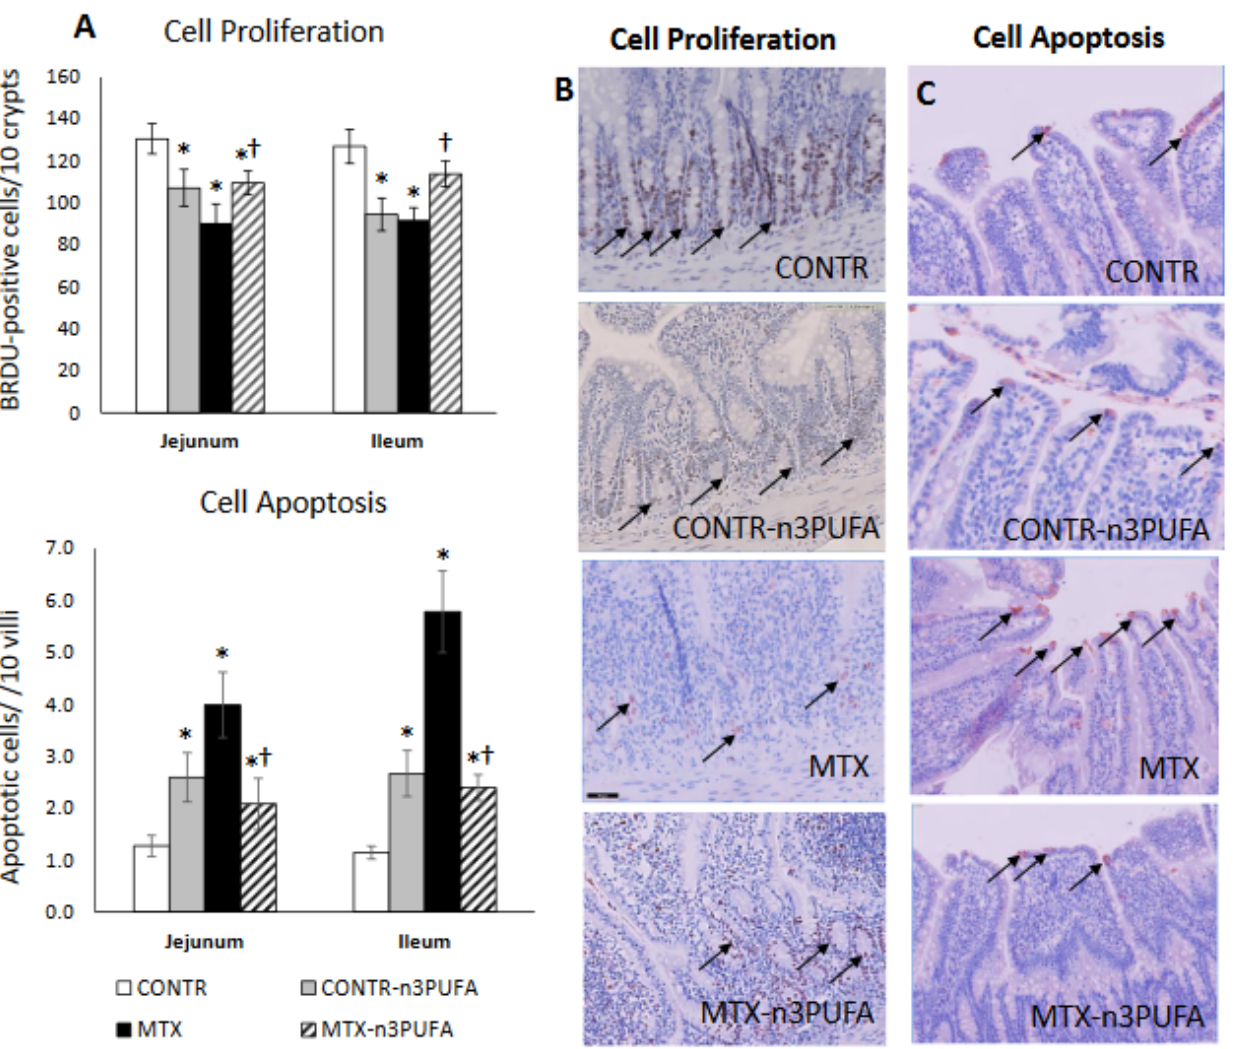
Figure 4. Effects of MTX and n-3 PUFAs on crypt cell proliferation ( A , B ) and apoptosis ( A , C ). Crypt cell proliferation was assessed using 5-bromodeoxyuridine (5-BrdU). Immunohistochemistry for Caspase-3 was performed for identification of apoptotic cells. Values are mean ± SEM. CONTR- control, MTX-methotrexate, n-3 PUFAs. * p < 0.05 all groups vs. CONTR rats, † p < 0.05 MTX+n-3 PUFAs vs. MTX rats.